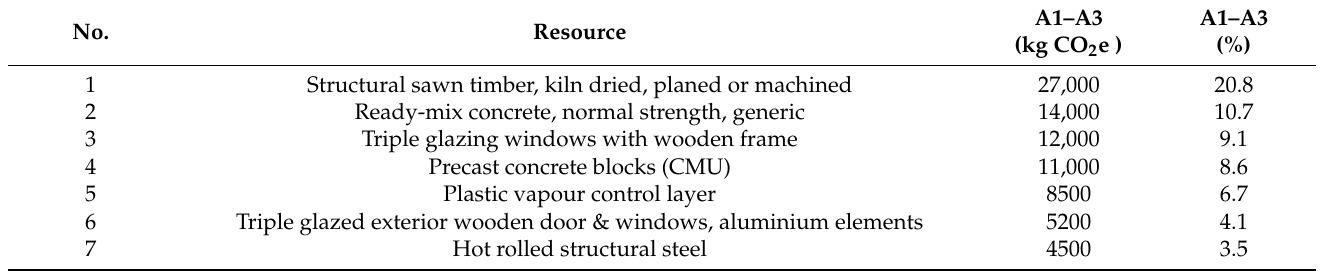
Table 2. The building materials with the largest Product Stage (A1–A3) GWP (kg CO 2 e, rounded) contribution and their respective percentage contribution. (NB: Only materials contributing > 1000 kg CO 2 e, or >0.8%, are